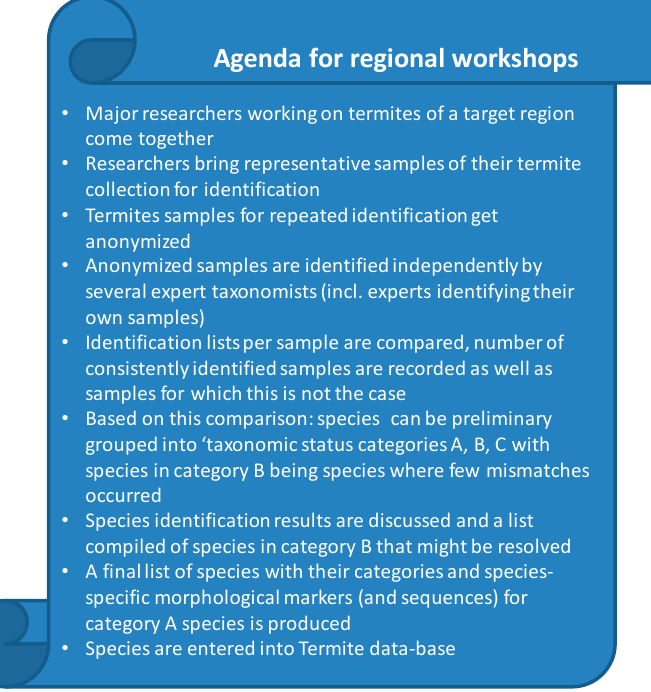
Figure 3. Proposal for a worldwide termite taxonomy initiative. Suggested procedure for regional taxonomy workshops.